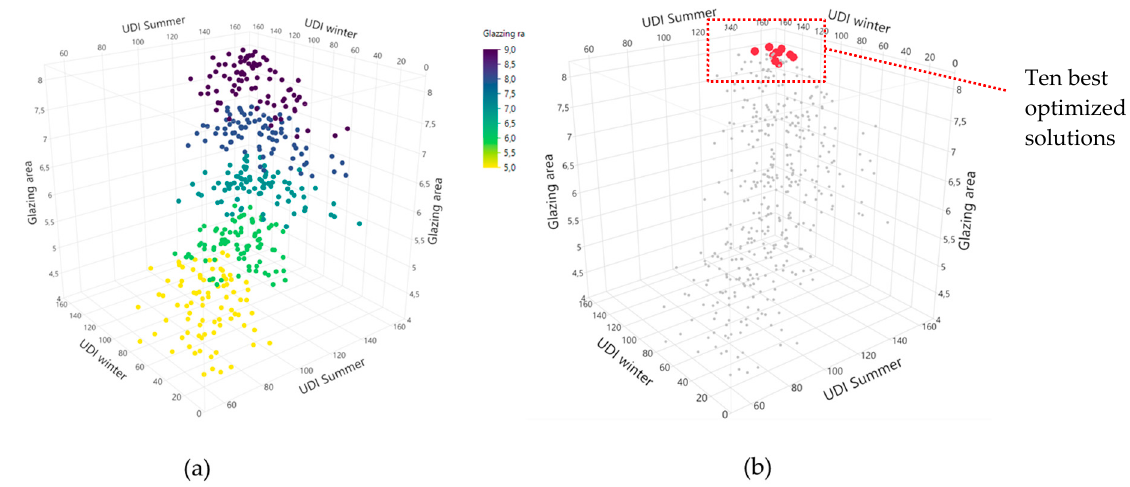
Figure 14. Scatterplot for daylight objectives iteration results: ( a ) overall generations; ( b ) optimized solution from FF calculation (red) .